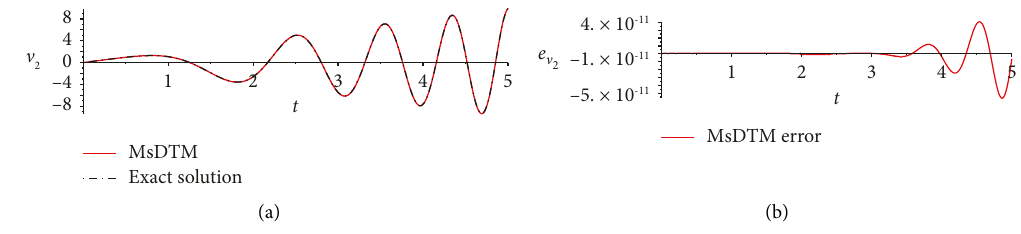
Figure 10: The approximate solution component v